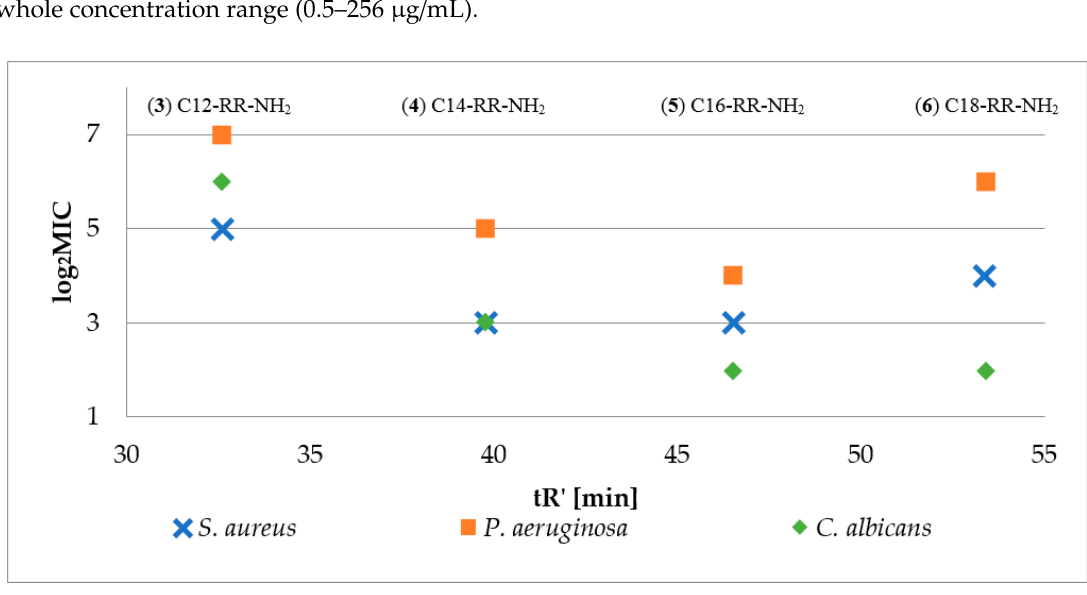
Figure 2. Antimicrobial activity (log 2 MIC) of reference lipopeptides ( 3 – 6 ) against S. aureus ATCC 25923 , P. aeruginosa ATCC 9027 , and C. albicans ATCC 10231 and fatty acid chain length (nC) versus adjusted retention time.